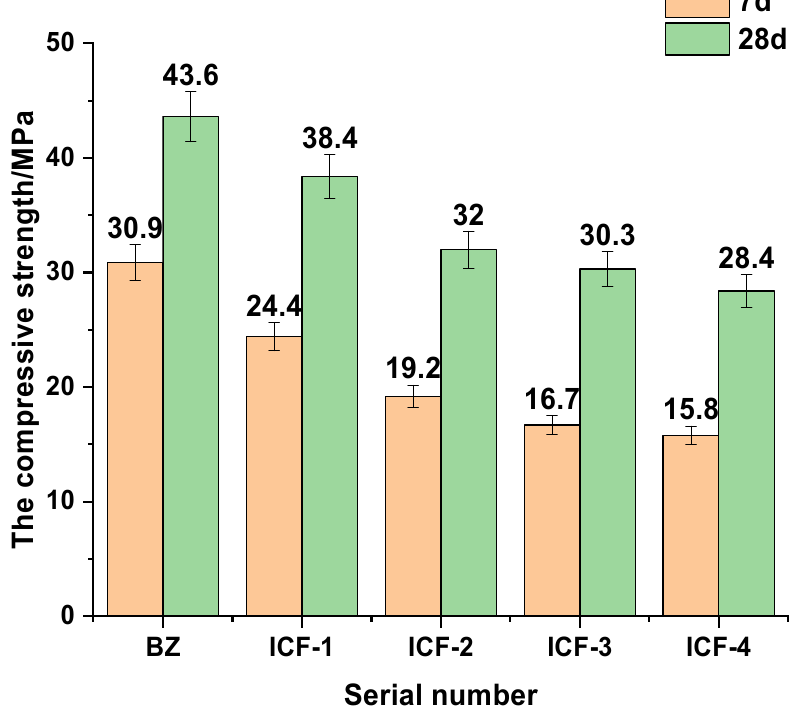
Figure 3. Compressive strength tests with different substitution rates.